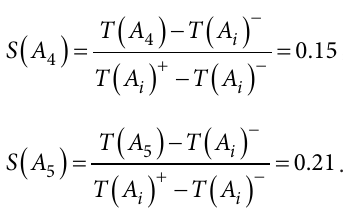
Table 4. The ranking order of alternatives with different value of θ